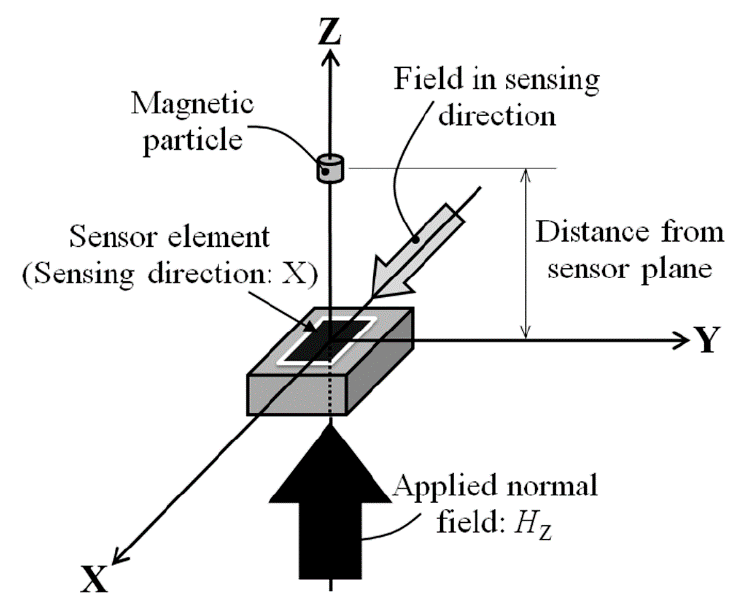
Figure 1. Schematic explanation of measurement system [21].